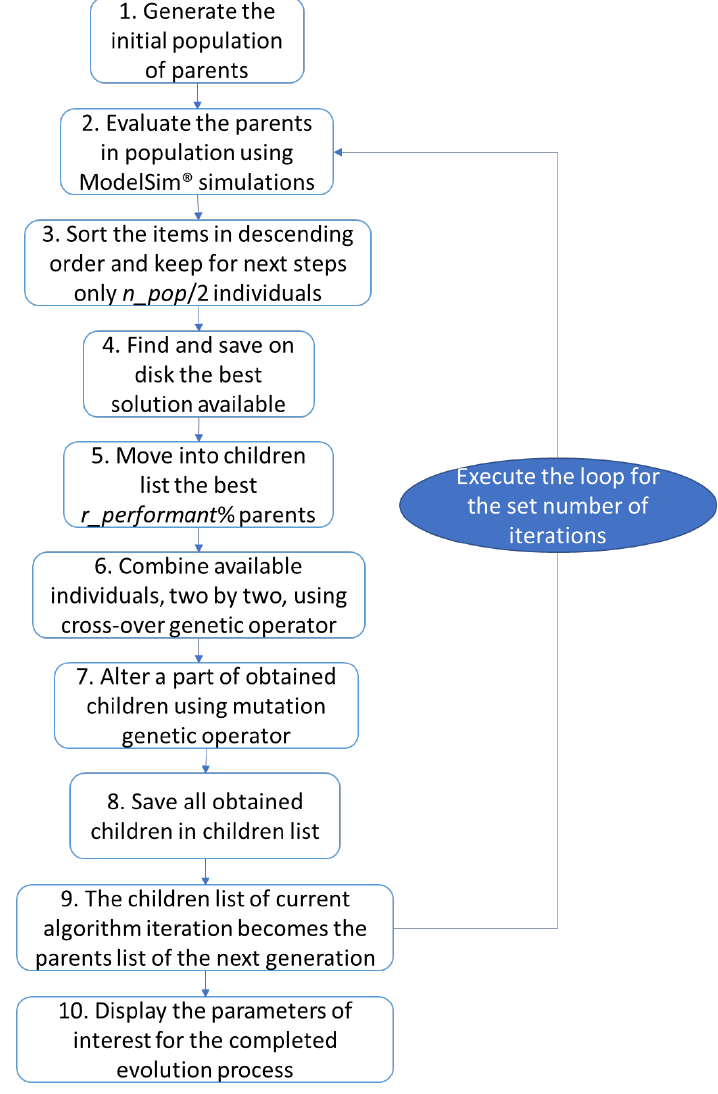
Figure 6. Flowchart of the general structure of the developed genetic algorithm.